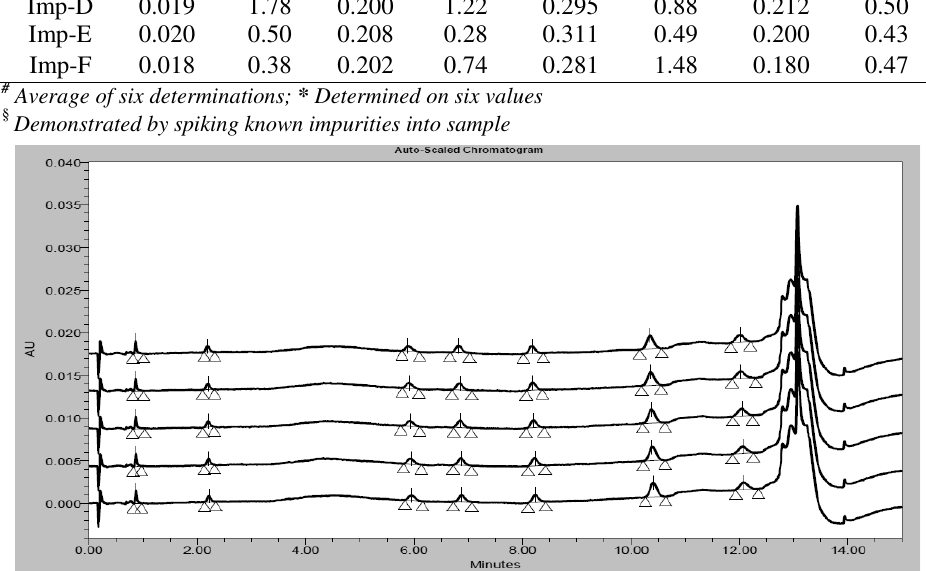
Figure 7. Overlay chromatograms of precision at LOQ level